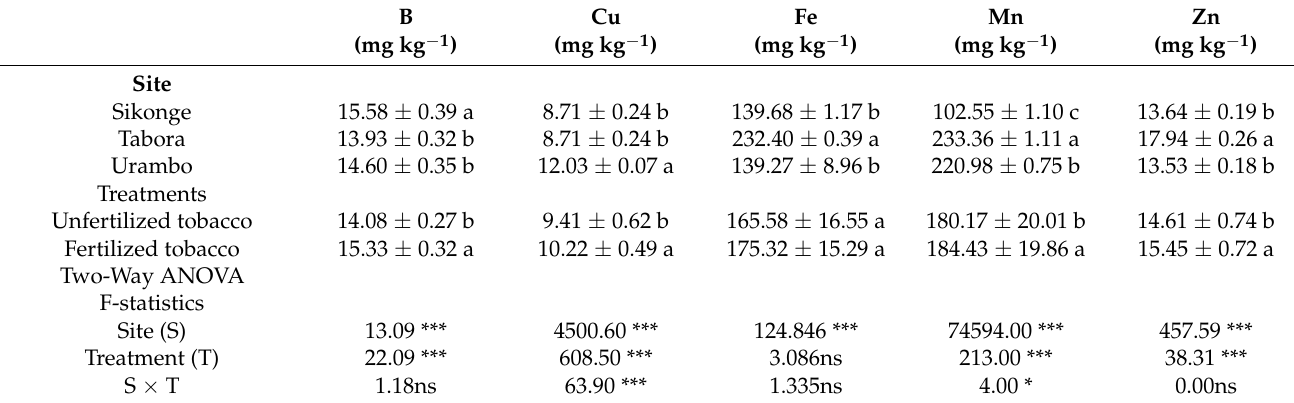
Table 2. Micronutrient concentrations of tobacco plant cultivated on fertilized relative to unfertilized soils.